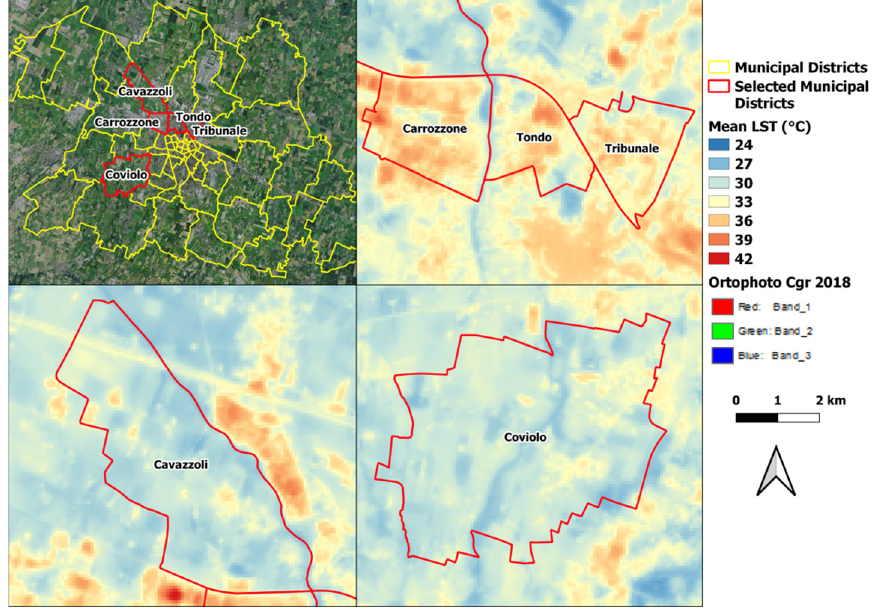
Figure 5. LST map of the 5 chosen LCZs, computed as the mean of all the LST maps from 2016 to 2021.